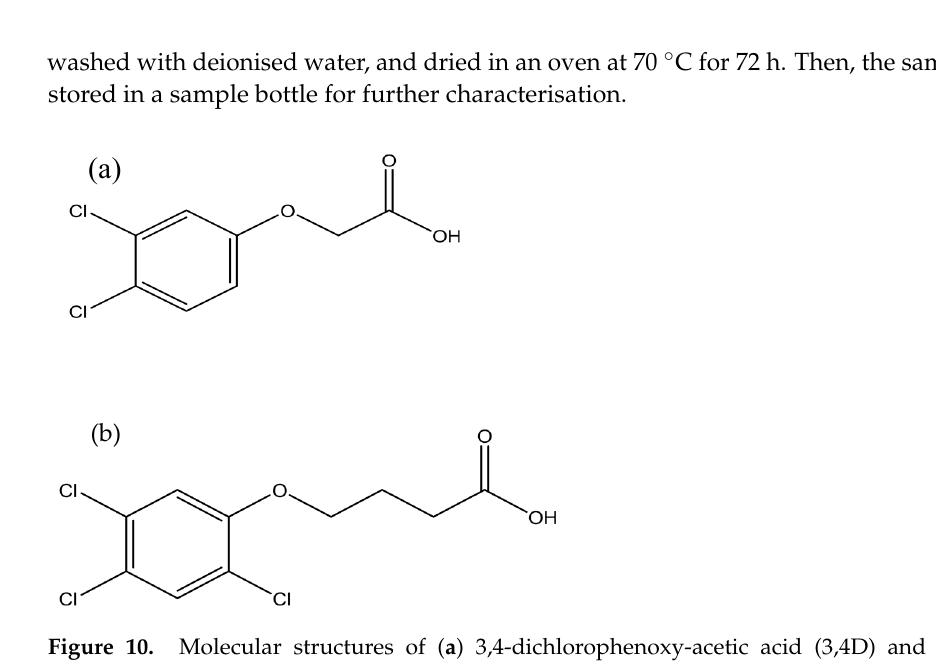
Figure 10. Molecular structures of ( a ) 3,4-dichlorophenoxy-acetic acid (3,4D) and ( b ) 2,4,5-trichlorophenoxybutyric acid (TBA).